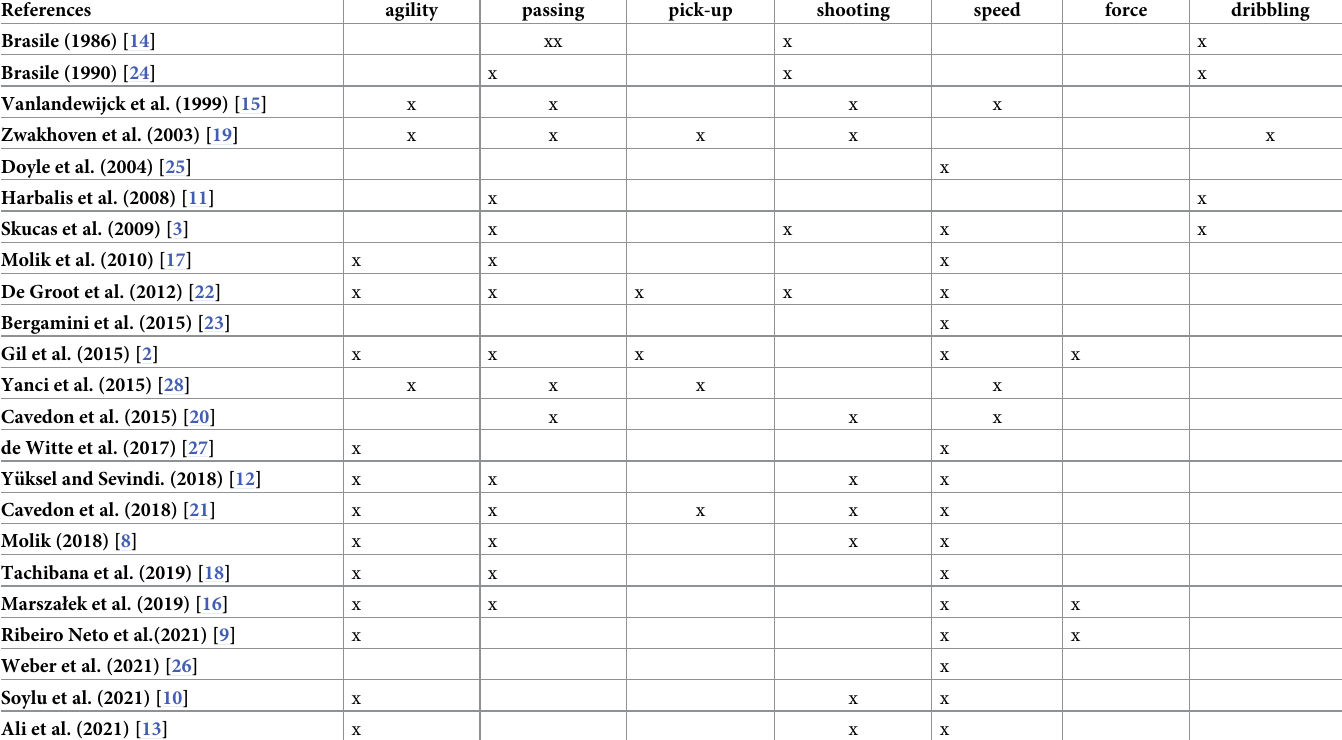
Table 4. Ability of wheelchair skills